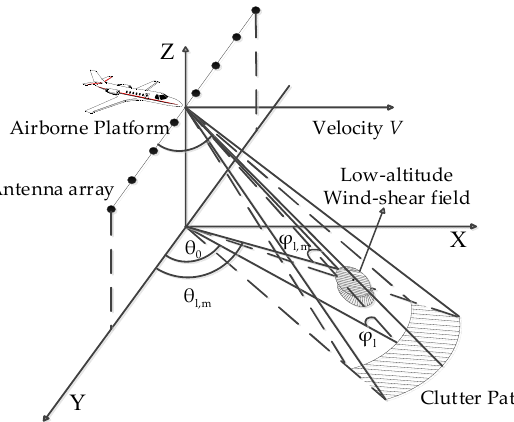
Figure 1. The model of low-altitude windshear detected by an airborne weather radar forward- looking array.